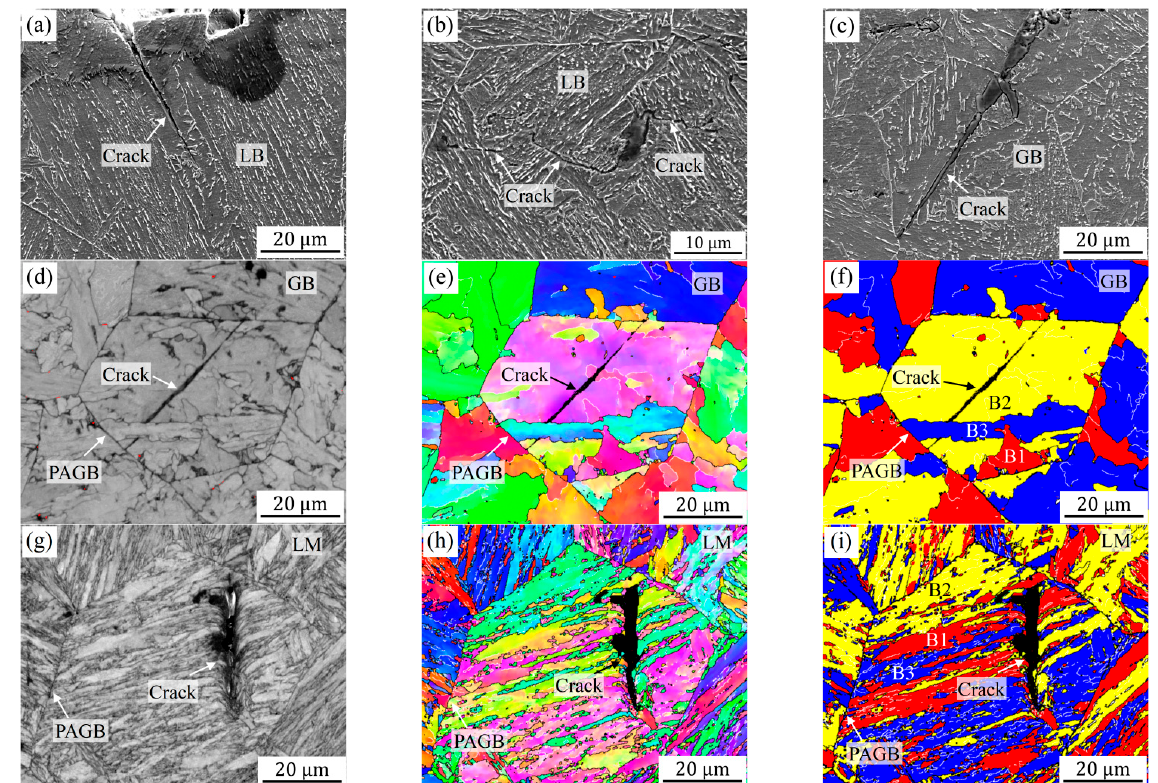
Figure 9. Secondary cracks observed on the fractured V-notch Charpy samples with 0.04 ( a – f ) and 0.12 ( g – i ) wt.% C by using SEM ( a – c ) and EBSD ( d – i ) under the different heat inputs: ( a , g – i ) 10 kJ/cm, ( b ) 20 kJ/cm and ( c – f ) 50 kJ/cm.